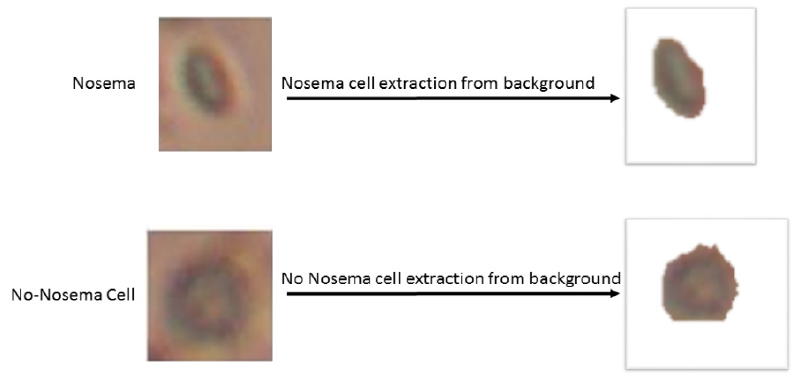
Figure 4. Example of a Nosema cell and non-Nosema object extraction from its backgrounds. The number of texture parameters is 6 and they are the measurement of the entropy of RGB and HSV channels; it can be defined as a logarithmic measurement of the number of states with a significant probability of being occupied. The input intensity images are the blue, red, green and yellow channels. Furthermore, the Hue and saturation masks’ randomness is calculated. The value/lightness channel was dropped since it does not give any extra information. Suppose x i is the set of pixels with the color/channel i of the